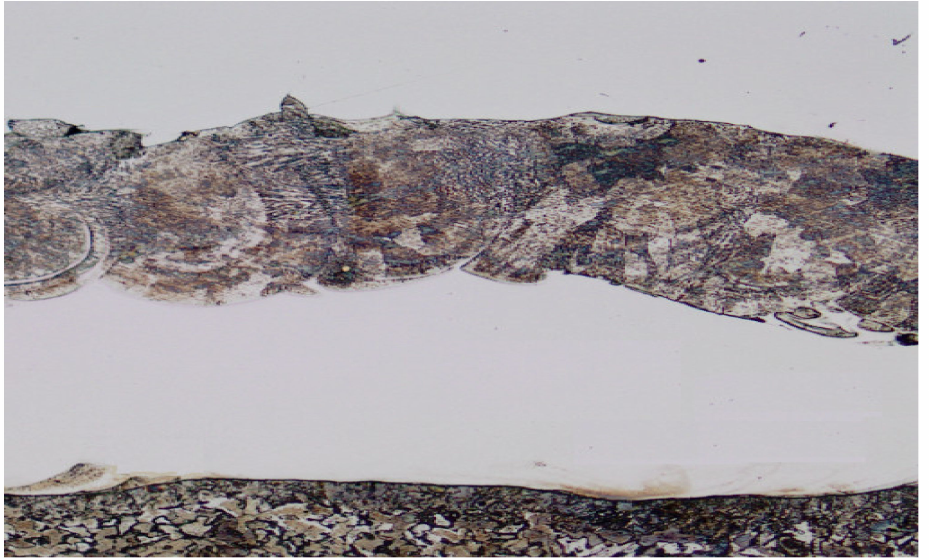
Figure 14. Microstructure of a multilayered LDED specimen from steel PR-12H18N9T and alloy